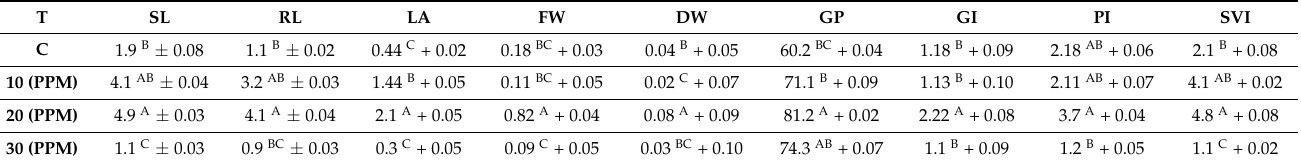
Table 3. Germination and biomass studies of Zea mays L. treated with different concentrations of ZnO NPs (10, 20, and 30 ppm) in a Petri plate